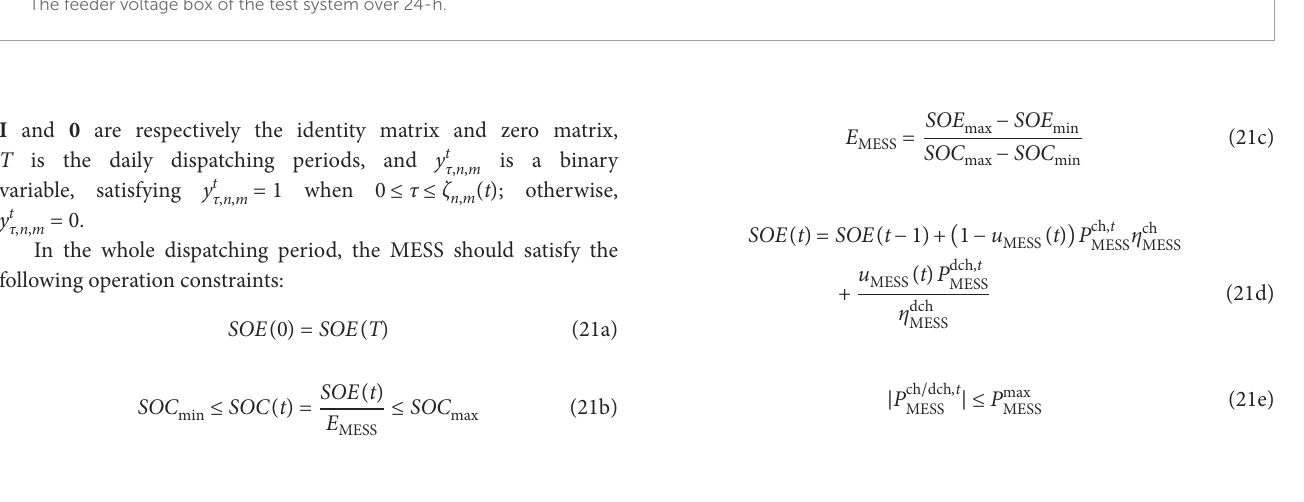
FIGURE 5 The feeder voltage box of the test system over 24-h.